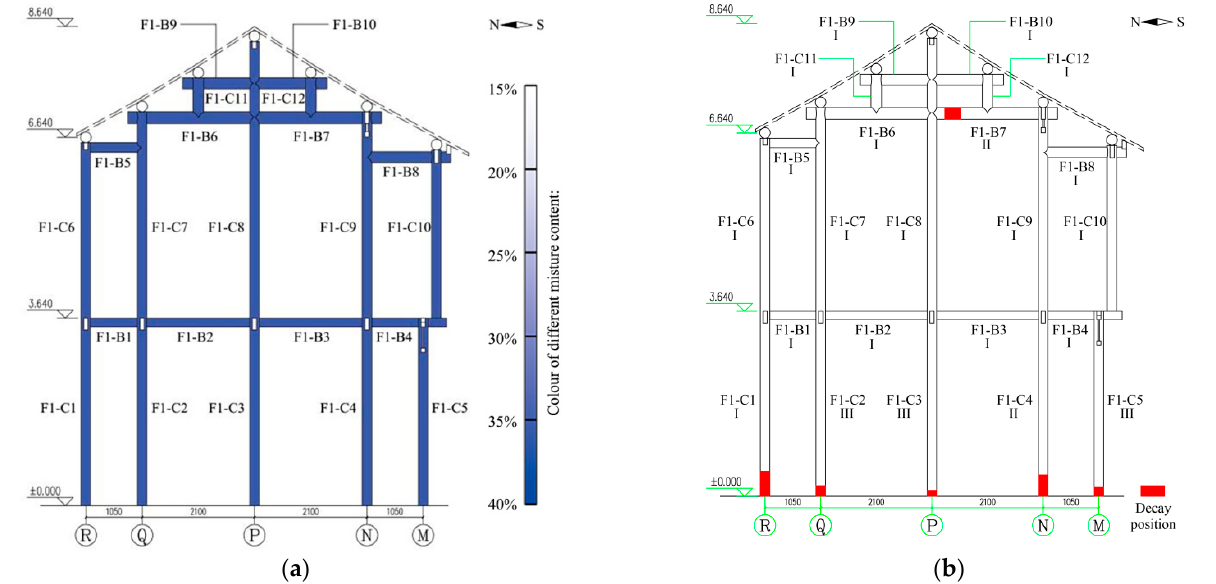
Figure 12. Moisture content and decay of F1 in Fujiu Zhou house; ( a ) schematic diagram of moisture content; ( b ) schematic diagram of decay position and decay grade.